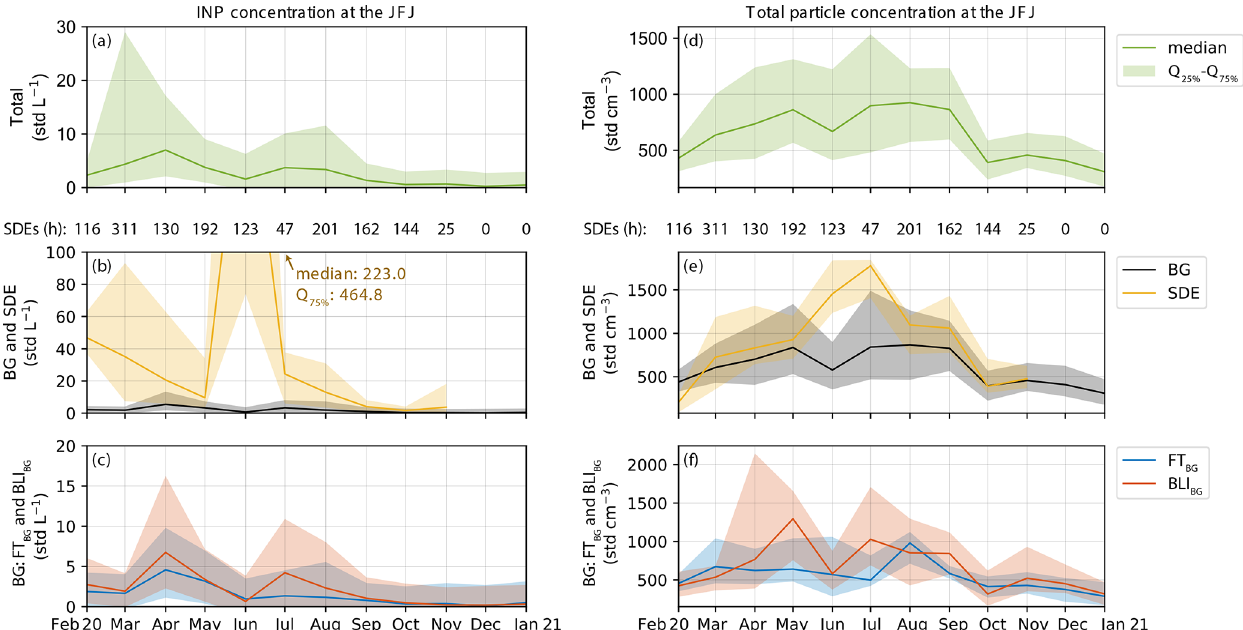
Figure 2. Monthly median and 25th to 75th percentiles ( Q 25% – Q 75% ) of total INP concentrations (a) , periods with Saharan dust events (SDE) or background (BG) conditions (b) , and INP concentrations measured in free tropospheric background (FT BG ) or boundary layer intruded background (BLI BG ) air masses (c) , and analogous for the total particle concentrations (d, e, f) at JFJ between February 2020 and January 2021. The numbers above (b) and (e) indicate the total hours of SDEs during each month. There were no SDEs in December 2020 and January